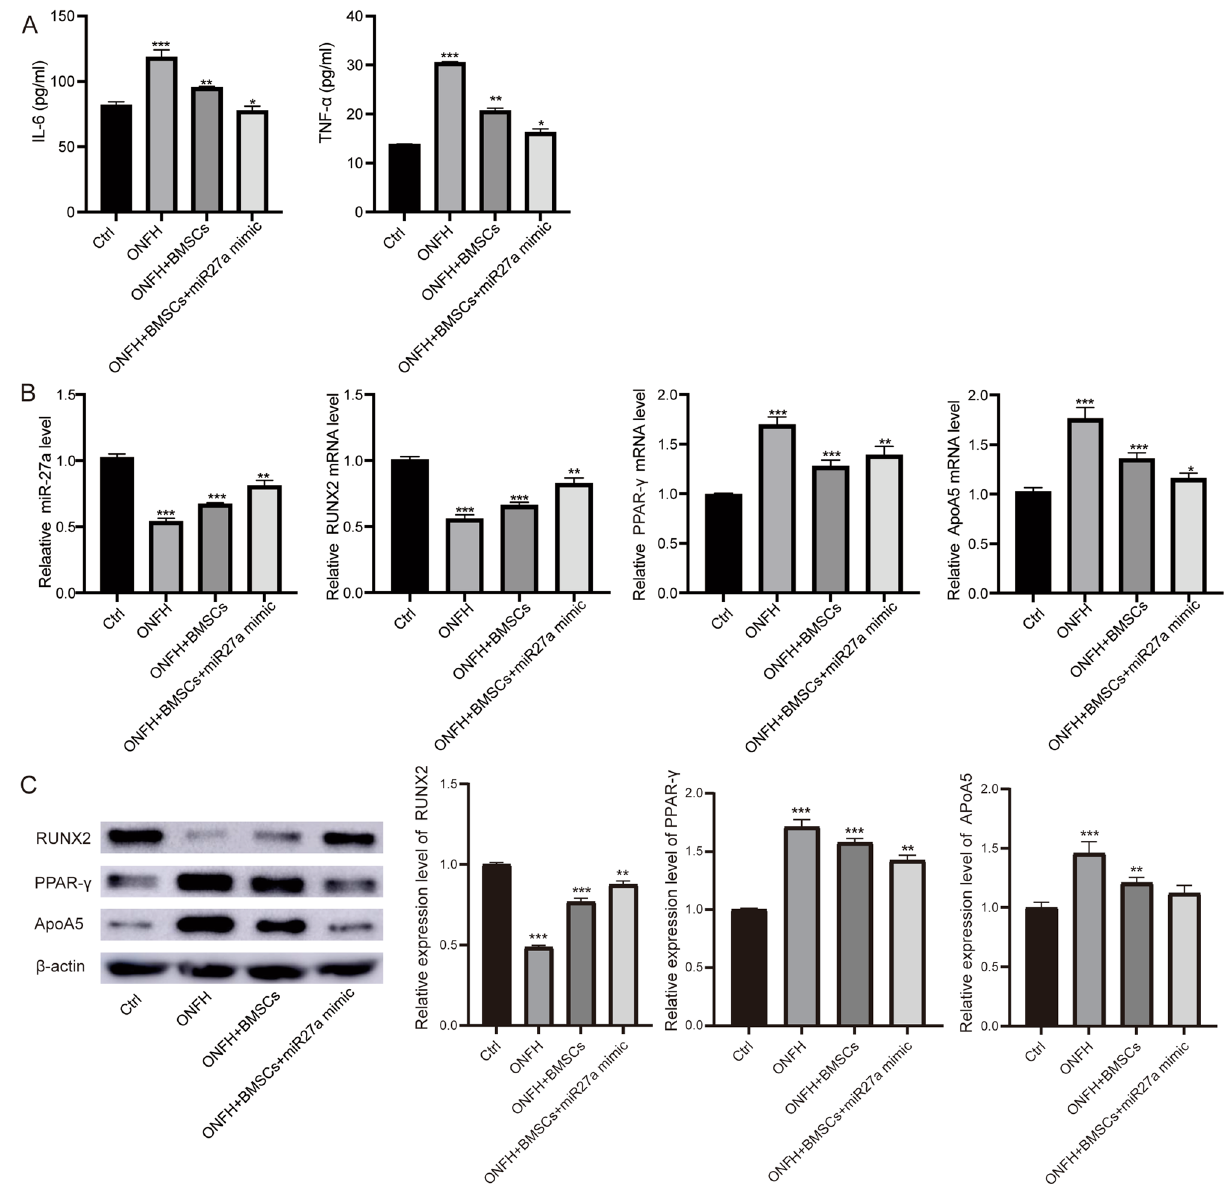
Figure 5. Overexpression of miR-27a changed gene expression associated with inflammation, adipogenic and osteogenic differentiation in steroid-induced ONFH rat. ( A ) The levels of IL-6 and TNF-α in serum of rats were detected using ELISA. ( B )The mRNA levels of miR-27a, Runx2, PPAR-γ and ApoA5 were detected by qRT ‐ PCR in different group rats. ( C ) The protein expression of miR-27a, Runx2, PPAR-γ and ApoA5 were detected by WB in different group rats. * P < 0.05, ** P < 0.01, *** P <